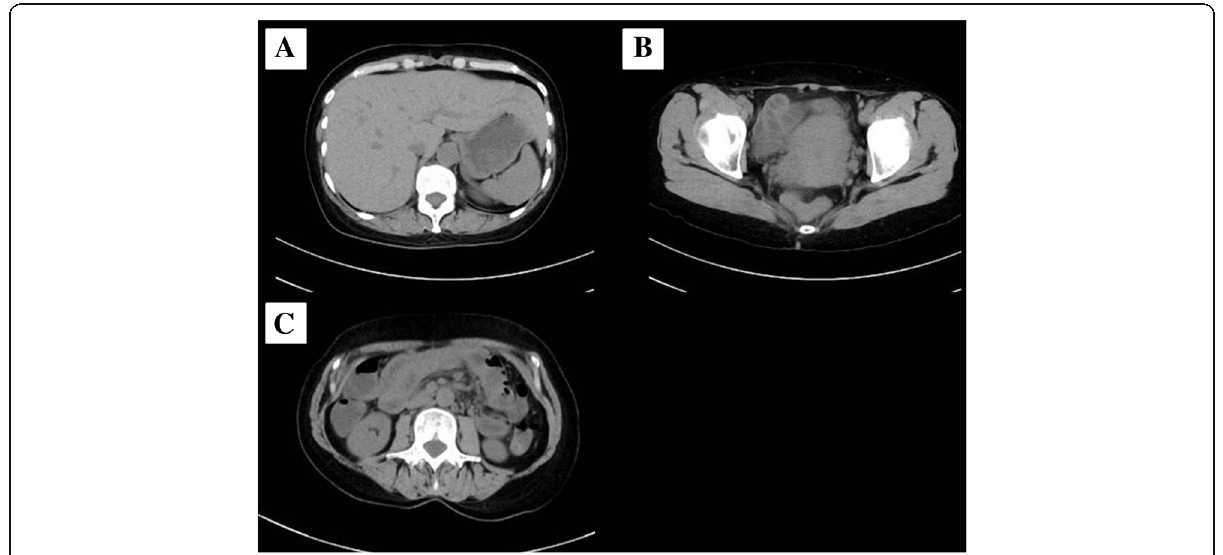
Fig. 1 Abdominal computed tomography examination on admission. Abdominal computed tomography examination on admission showed no ascites ( a , b ) and a thickened wall throughout the entire small intestine ( c